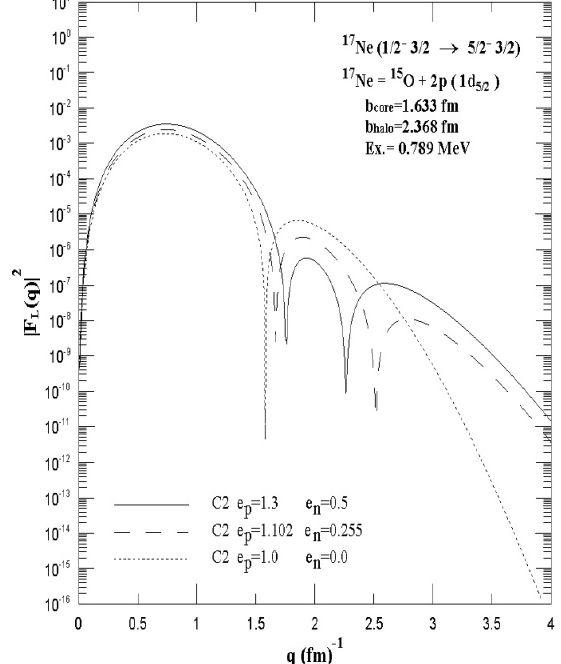
Fig. 11: The calculated inelastic longitudinal C2 form factors of 17 Ne with two protons in orbit and for ( 2325   TJ  ) 1d 5/2